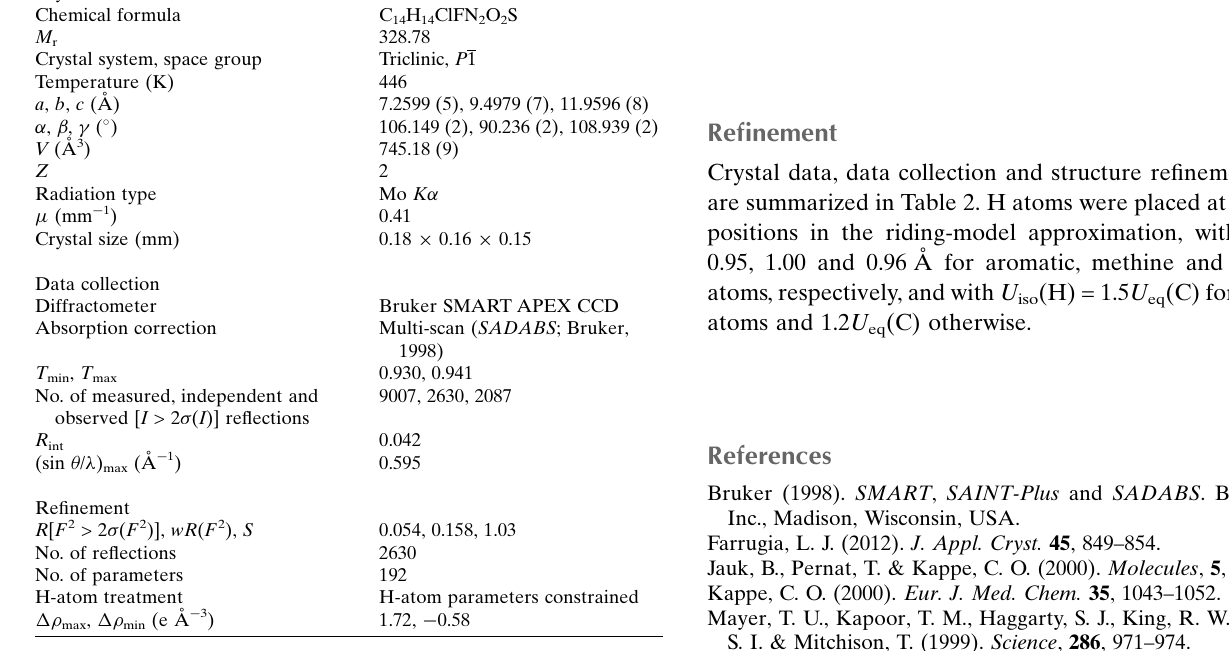
Table 2 Experimental details. Crystal data Chemical